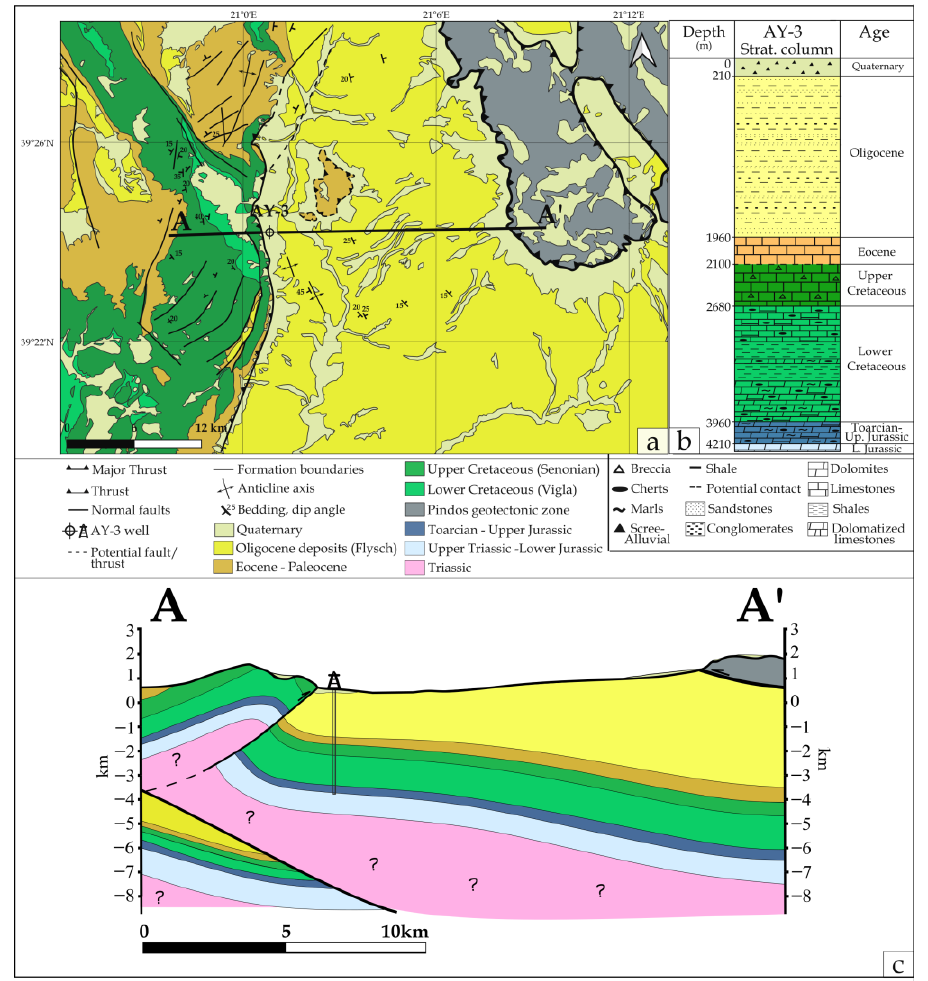
Figure 2. ( a ) Geological map of the AY-3 well location area in the Internal Ionian geotectonic zone (compilation of [15,16,18,58,59]). ( b ) Stratigraphic column of the AY-3 well, reconstructed after [9] and ( c ) Simplified cross-section (A-A’) in W–E direction crossing a backthrust sequence, the AY-3 well and the Pindos thrust from west to east. Question marks “?” indicate uncertainty about the related displayed layers.